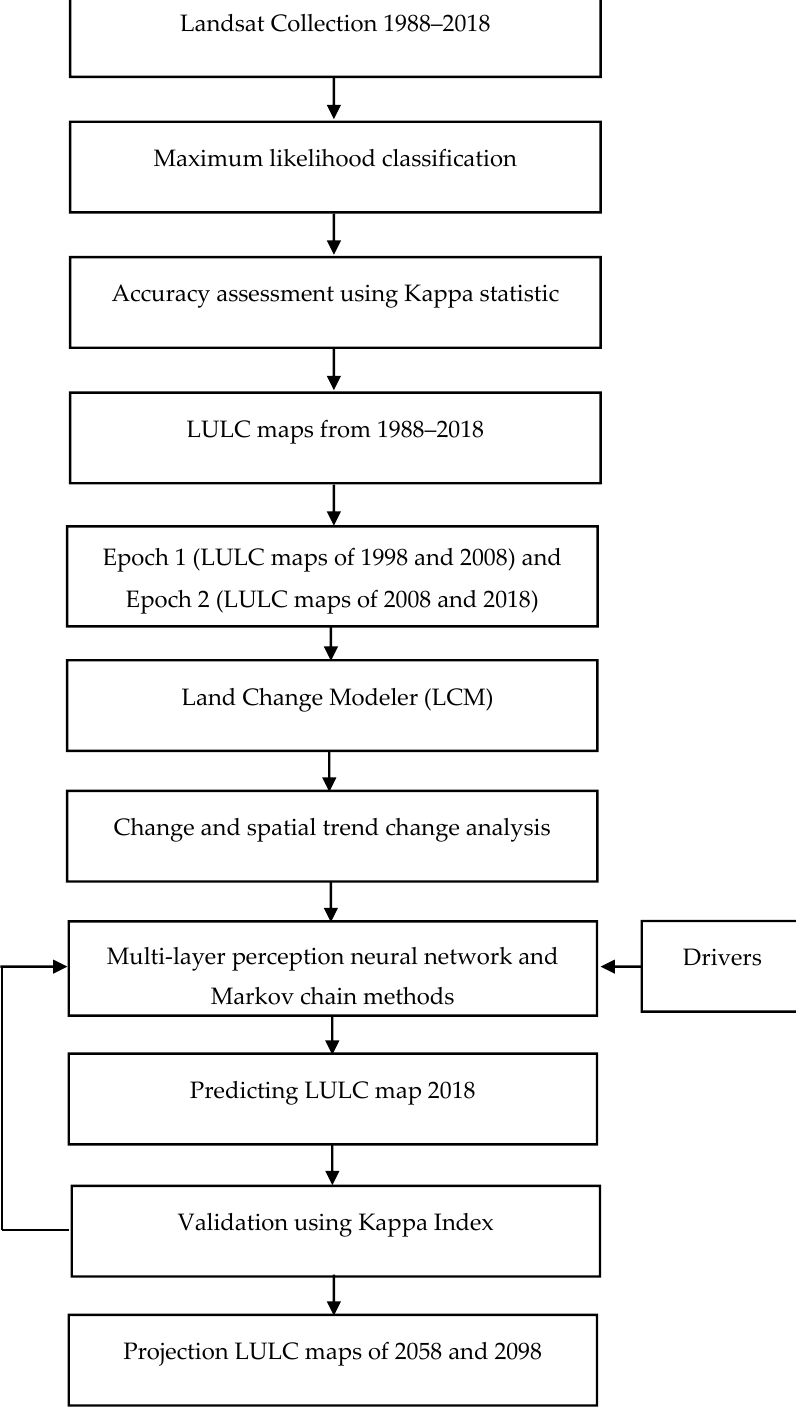
Figure 4. Overview of the methodology of land use and land cover (LULC) maps and prediction in the upper Siem Reap River.